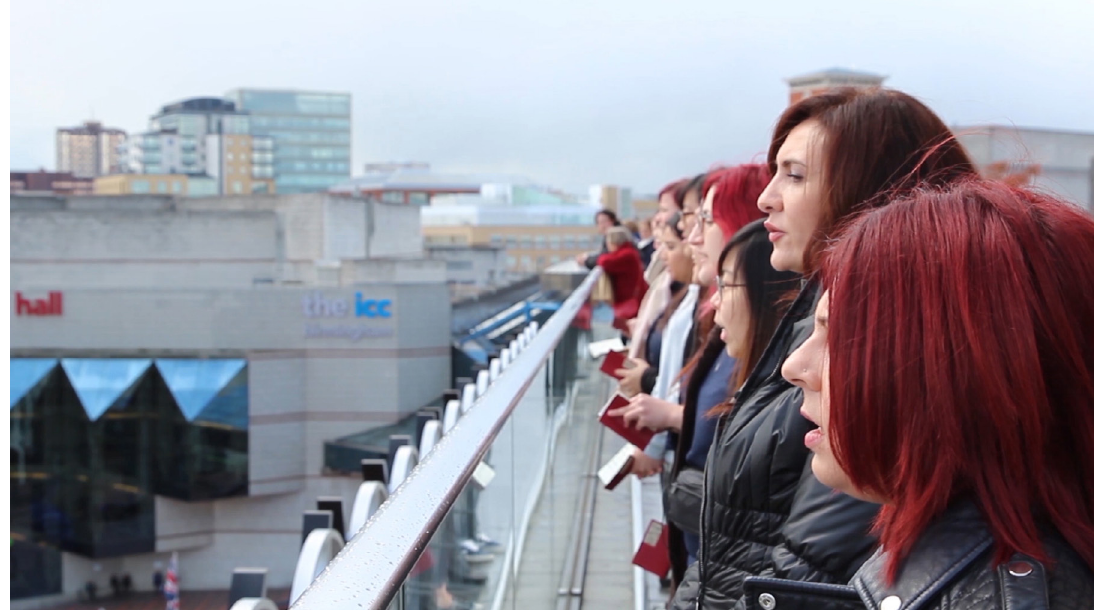
Figure 1. Video still from Translation Zones: A Stuttering which can be seen at: